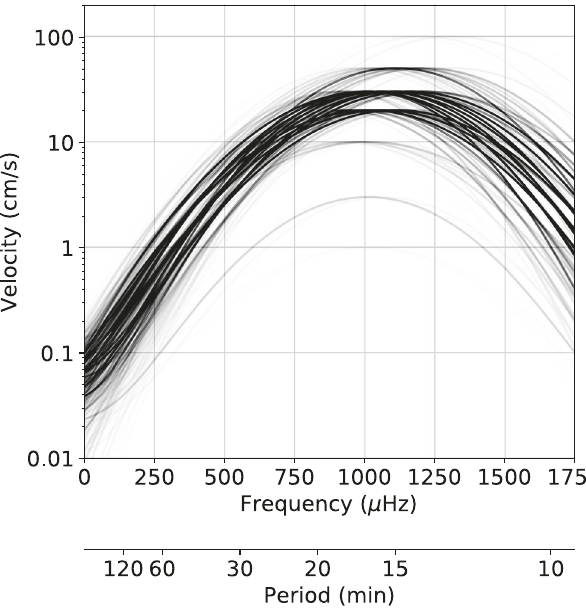
Fig. 4 | Recovered radial velocity pro fi le as a function of frequency. Each line corresponds to a different modelin the searchgrid. The opacity isproportionalto Akaike weights: darker lines are for more likely models (decreasing Δ AIC values), conversely, lighter lines are for gradually less probable models (increasing Δ AIC values). The spread of the lines provides an indication of the uncertainty of the recovered amplitude spectrum.